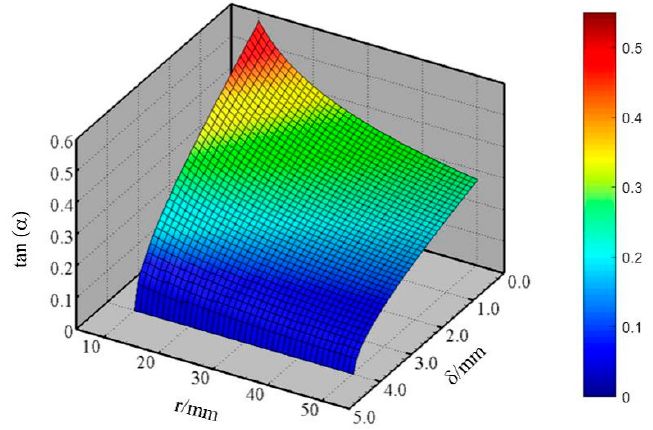
Figure 7. Force’s analysis of a single grain in the extrusion process.